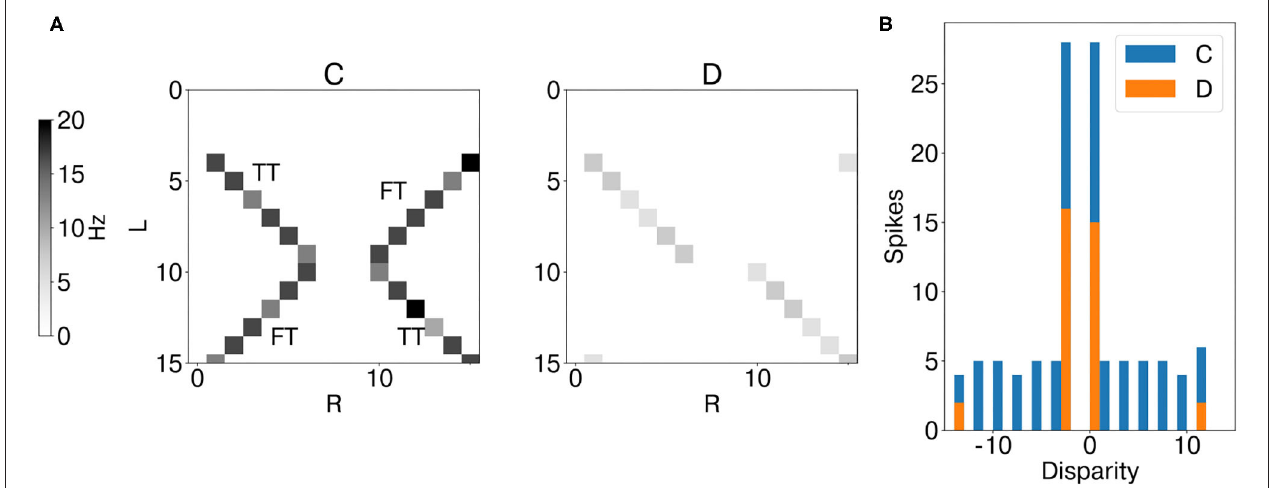
FIGURE 7 | Results of network emulation with the synthetic dataset. Mean firing rate of coincidence neurons (C, excitatory population) and disparity population (D) (A) . Histogram of encoded disparity values across the trial duration in both coincidence (blue) and disparity neurons (orange) (B) . As the activity clusters around the true disparity values (d = 0, d = − 3), the disparity population successfully resolves the stereo ambiguity.